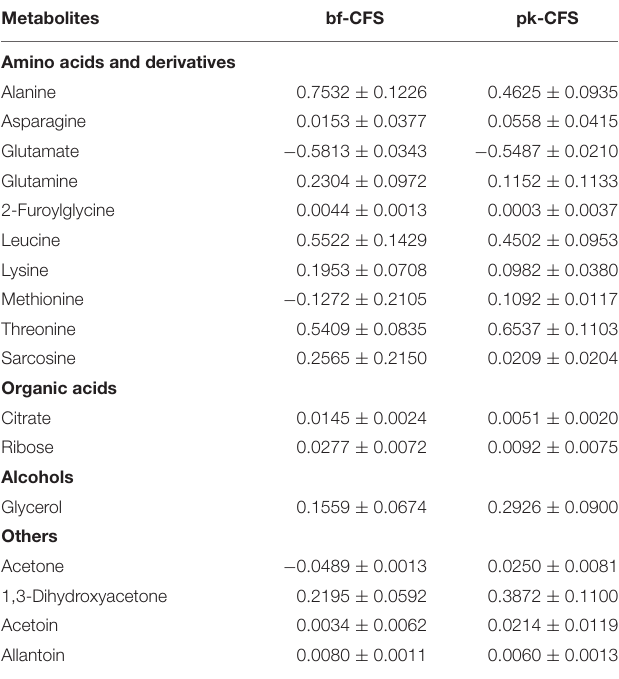
TABLE 2 | List of metabolites significantly different between Lactobacillus bf-CFS and pk-CFS ( p < 0.05) and concentrations, calculated as differences with respect to MRS medium [median value ± MAD